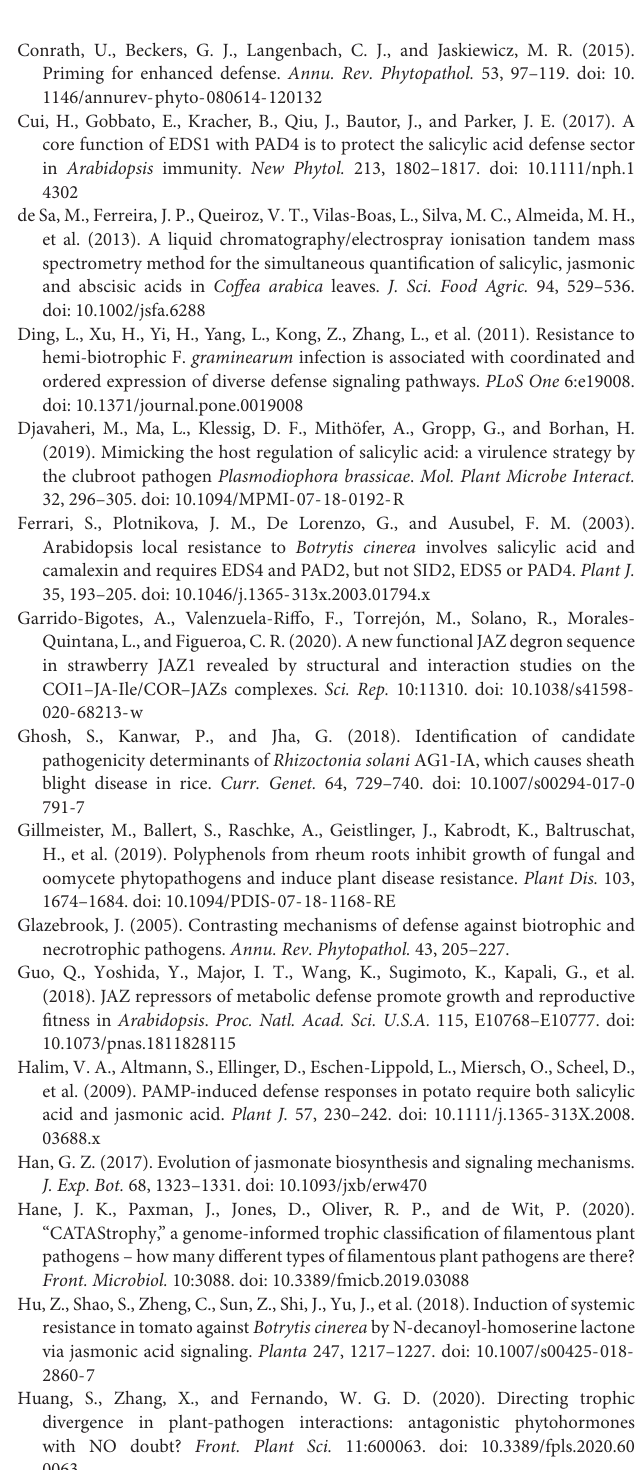
Supplementary Figure 7 | Graph showing the measurement of diameter of R. solani colony on PDA supplemented with phytohormones in increasing concentrations (A) MeJA, (B)